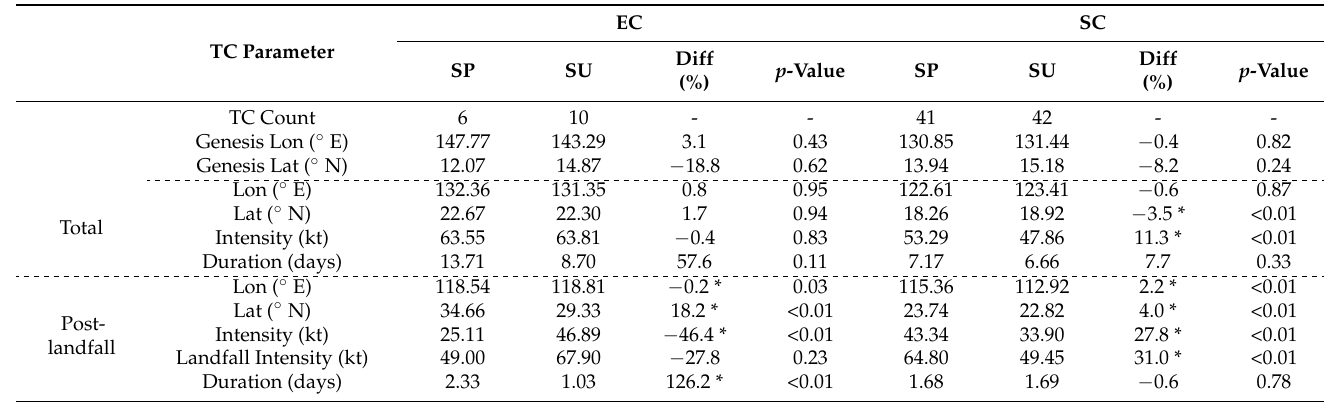
Table 4. Same as Table 3, but for TCs with different landfall locations (i.e., EC and